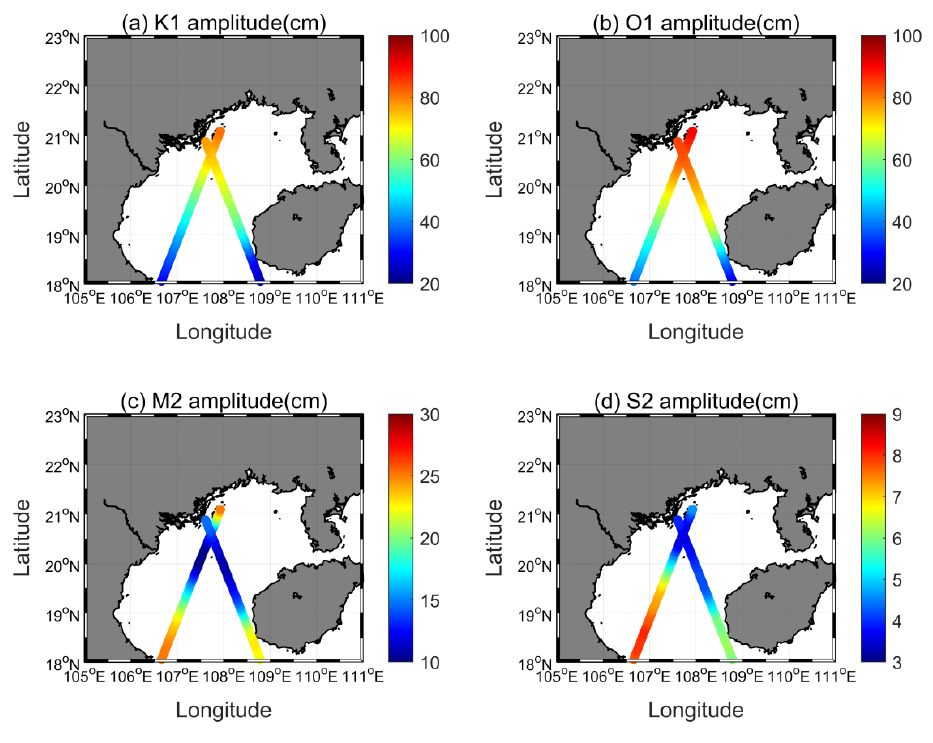
Figure 4. Tidal amplitudes of ( a ) K 1 , ( b ) O 1 , ( c ) M 2 , and ( d ) S 2 constituents extracted from T/P-Jason observations in the Gulf of Tonkin.